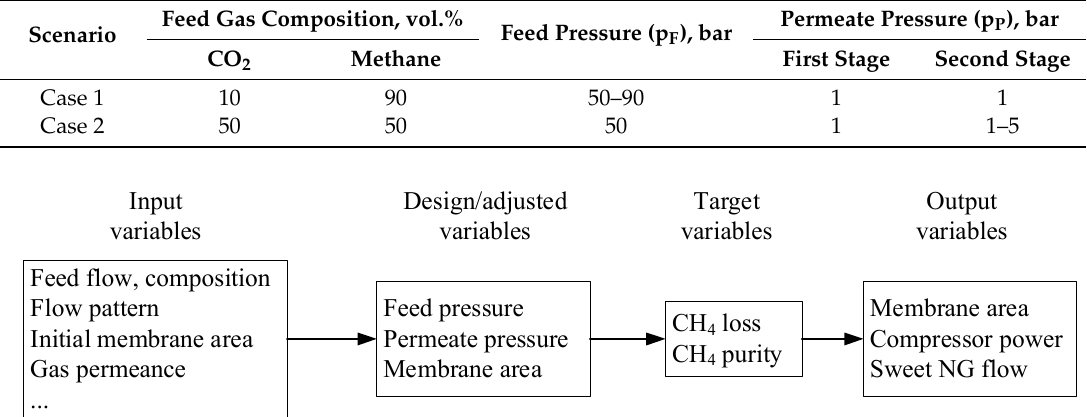
Figure 2. Illustration of simulation workflow of membrane systems for CO 2 removal from natural gas. Table 1. The simulation basis for natural gas sweetening using carbon membrane system.